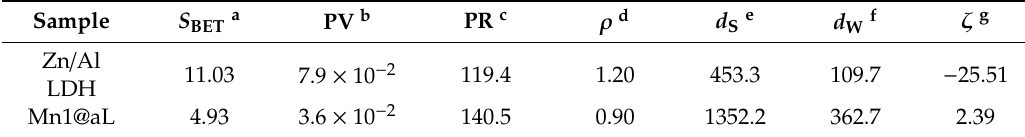
Table 1. Textural and physicochemical properties of the synthesized samples.